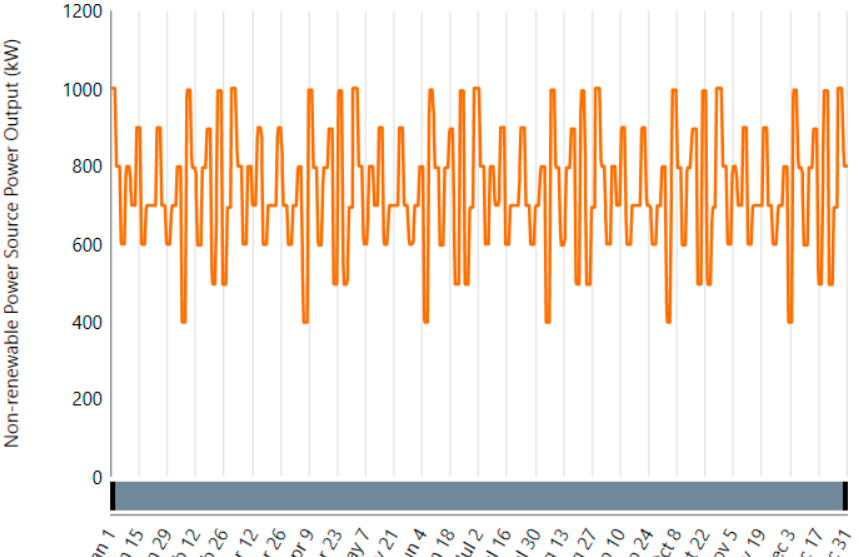
Figure 23. SMR output power profile.